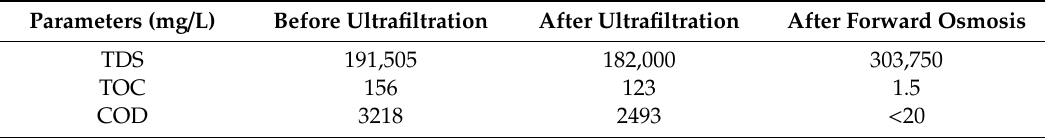
Table 2. Permeate quality